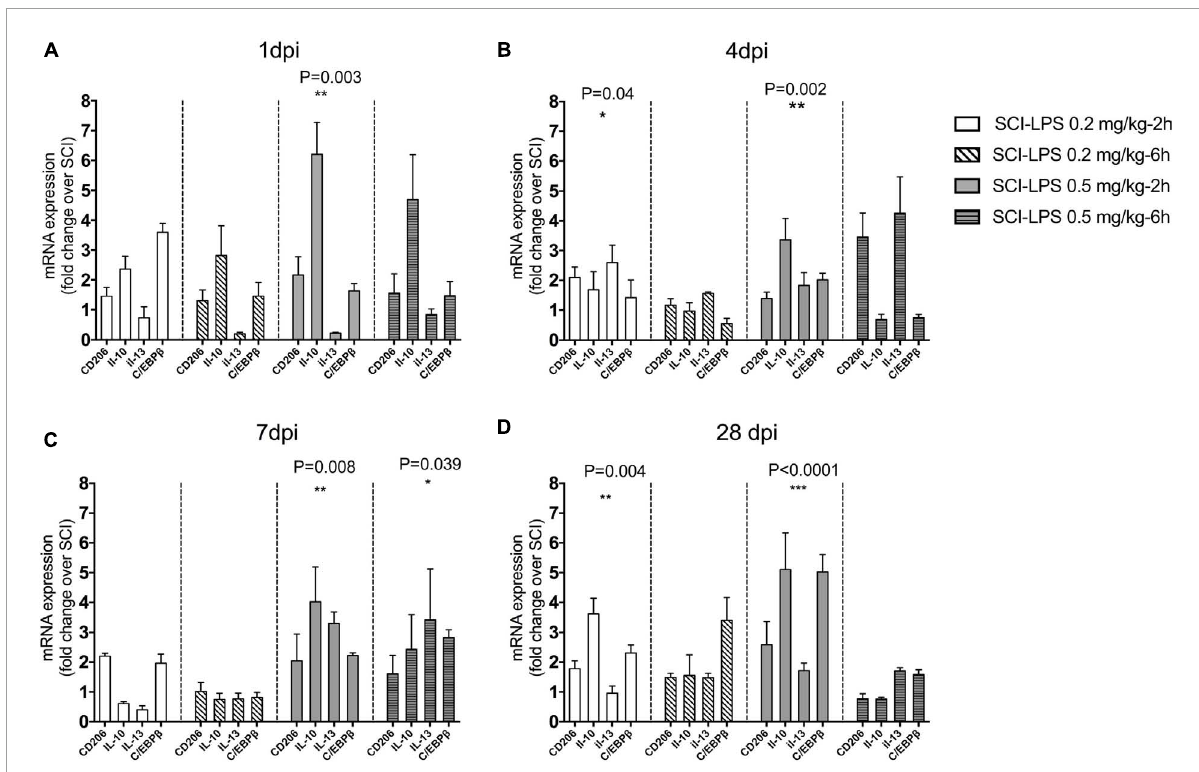
FIGURE4 Post-spinal cord injury medium-dose LPS treatment significantly increased anti-inflammatory gene expression in the lesion center. Adult male rats received the moderate contusion SCI and LPS treatment was initiated at 2 or 6 h post-SCI. Real-time PCR quantification was performed to evaluate anti-inflammatory markers at 1 (A) , 4 (B) , 7 (C) , and 28 (D) days after the SCI. Gene expression is normalized to the same-day SCI group. Upregulation of inflammatory gene for medium-dose LPS 0.5 mg/kg treatment groups at 1, 4, 7, and 28 days. * P < 0.05, ** P < 0.01, *** P < 0.001 versus SCI (main effect of treatment), n = 3, mean +